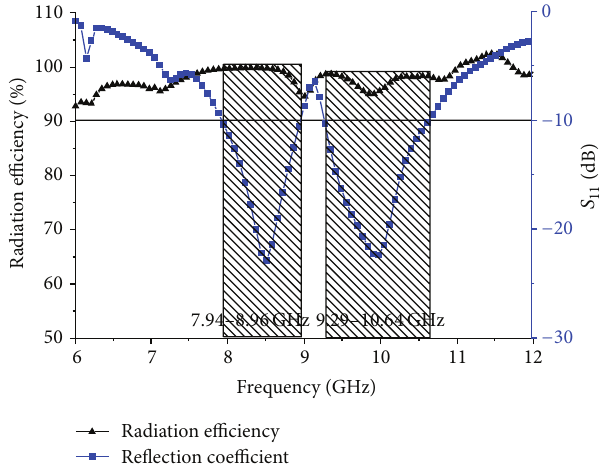
Figure 12: Proposed antenna radiation efficiency and 𝑆 11 .